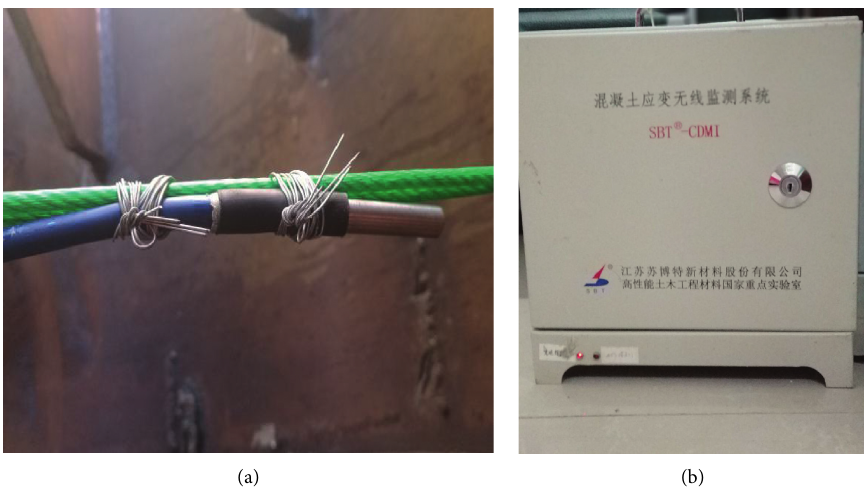
Figure 4: (a) Temperature sensor and (b) wireless data acquisition instrument.